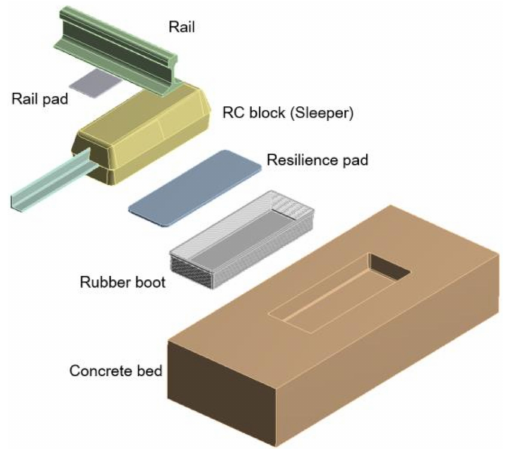
Figure 1. Slab-track system.